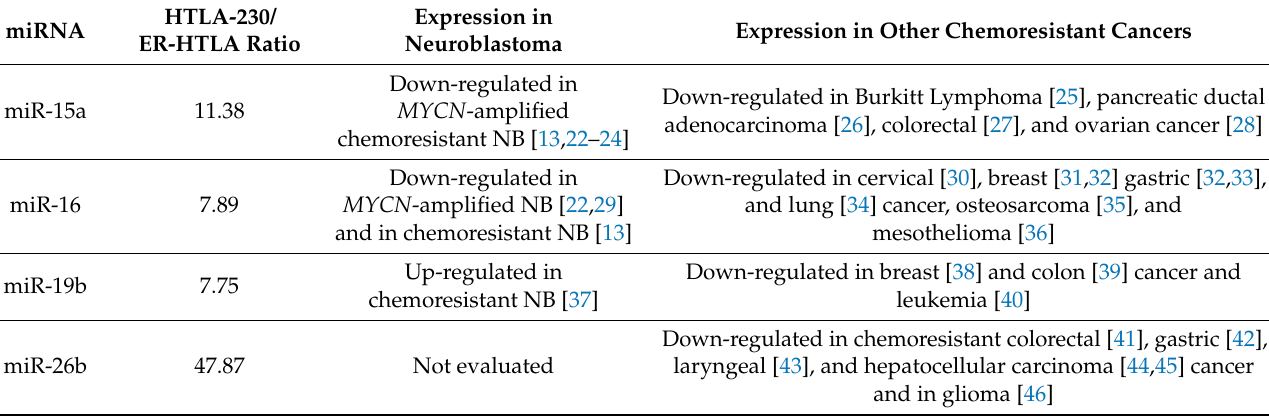
Table 1. miRNAs differently expressed in HTLA-230 and ER-HTLA cell lines that are involved in NB biology and in general cancer chemoresistance.